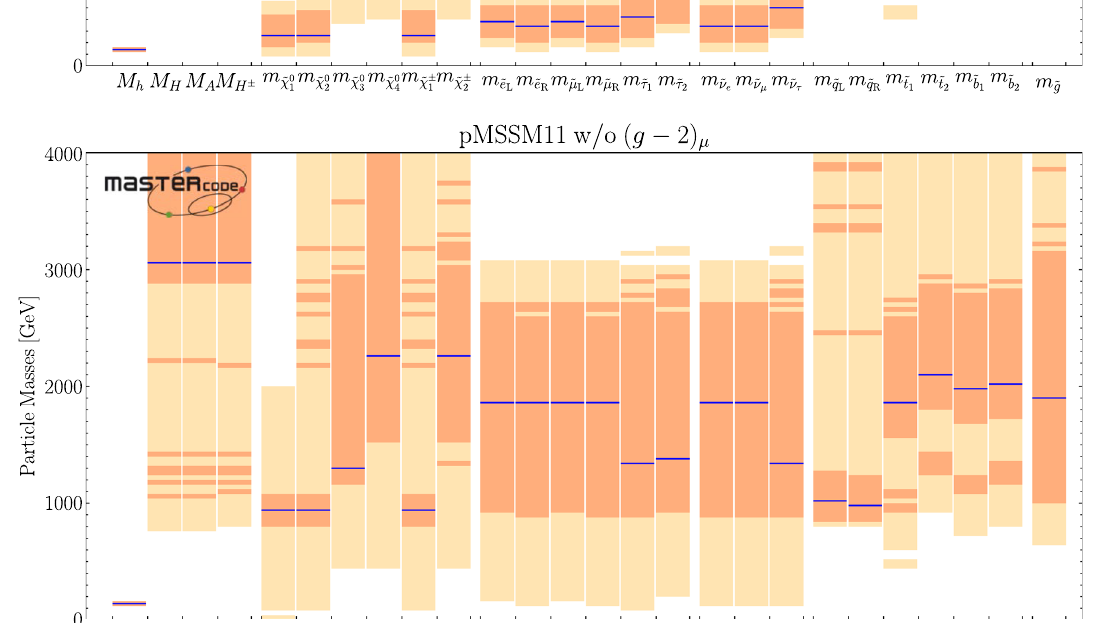
Fig. 23 Higgs and sparticle spectrum for the pMSSM11 with and without the ( g − 2 ) μ constraint applied (upper and lower panels, respectively). The values at the best-fit points are indicated by blue lines, the 68% CL ranges by orange bands, and the 95% CL ranges by yellow